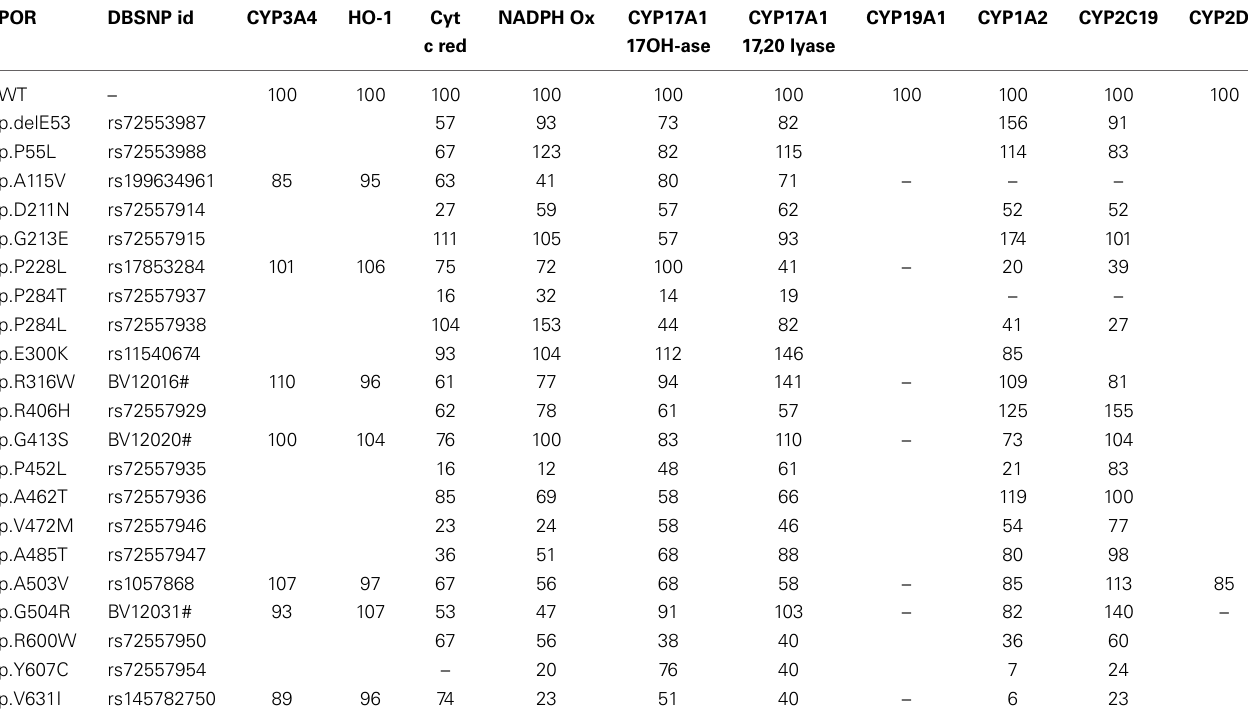
Table 3 | Influence of POR variants found in normal population on the enzyme activities of its redox partners.